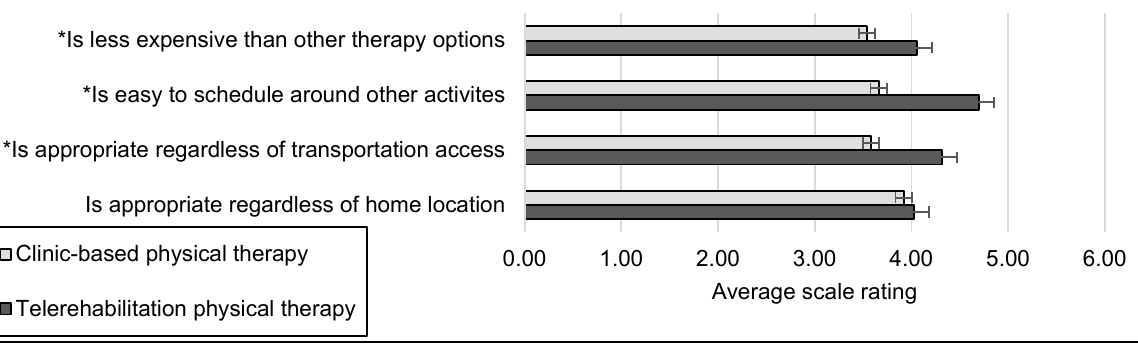
Average Likert-type Scale Ratings Concerning Convenience and Access to Physical Therapy Rehabilitation Services